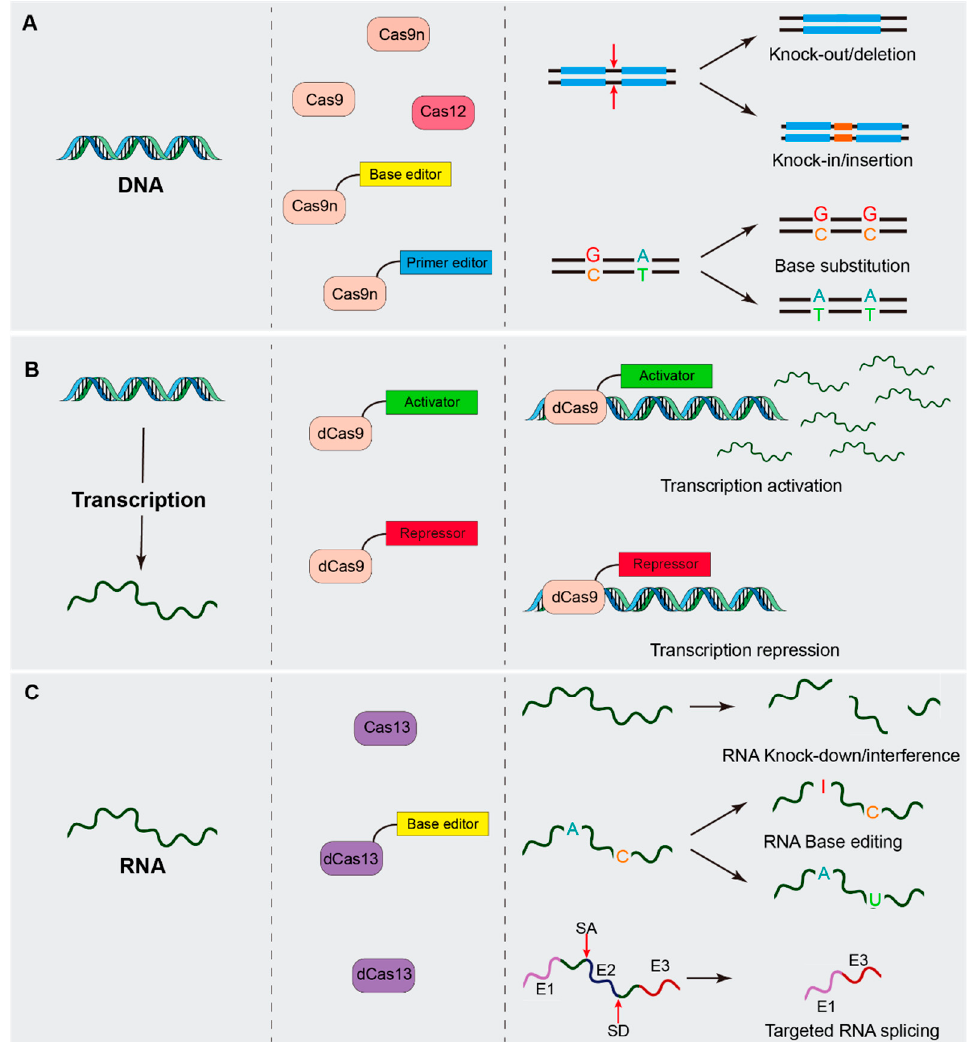
Figure 1. CRISPR/Cas systems mediated genetic manipulation. CRISPR-Cas systems allow multiple levels of genetic manipulation. ( A ) At the DNA level, Cas9, Cas9n and Cas12a are used for inducing dsDNA breaks for knock-out/deletion or knock-in/insertion. Cas9n can also be fused to base editors or primer editor to modify nucleotides in dsDNA for base substitution or base rewriting without introducing a dsDNA break. ( B ) During transcription, dCas9 can be fused to transcriptional activators, repressors, or epigenetic modifiers to activate or repress the transcription of single or multiple genes. ( C ) At the level of RNA, Cas13 can be used for targeted RNA manipulation. Cas13 can knock down specific RNA molecules by catalyzing RNA cleavage. Cas13 fused to base editors can be used to modify nucleotides in RNA molecules to achieve RNA base substitution or base rewriting. A single or multiple crRNA that bind to splice site motifs such as SA and SD combined with dCas13 protein can block specific exon from recognition by the splicing machinery, resulting in targeted RNA splicing. E1, exon 1; E2, exon 2; E3, exon 3; SA, splice acceptor site; SD, splice donor site.